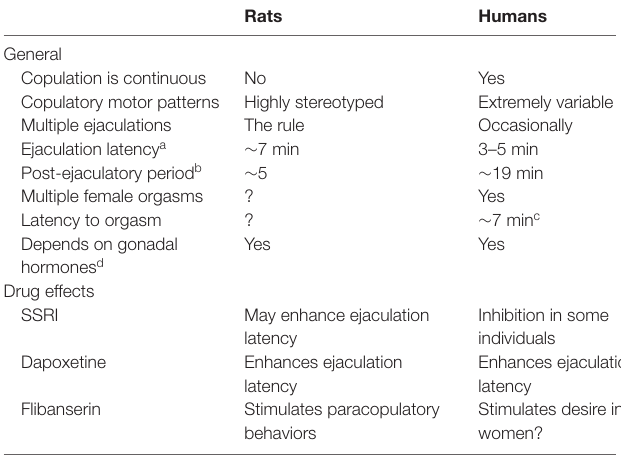
TABLE 1 | Comparison of some basic characteristics of copulatory behavior in rats and humans and the responses to drugs used clinically for the treatment of sexual